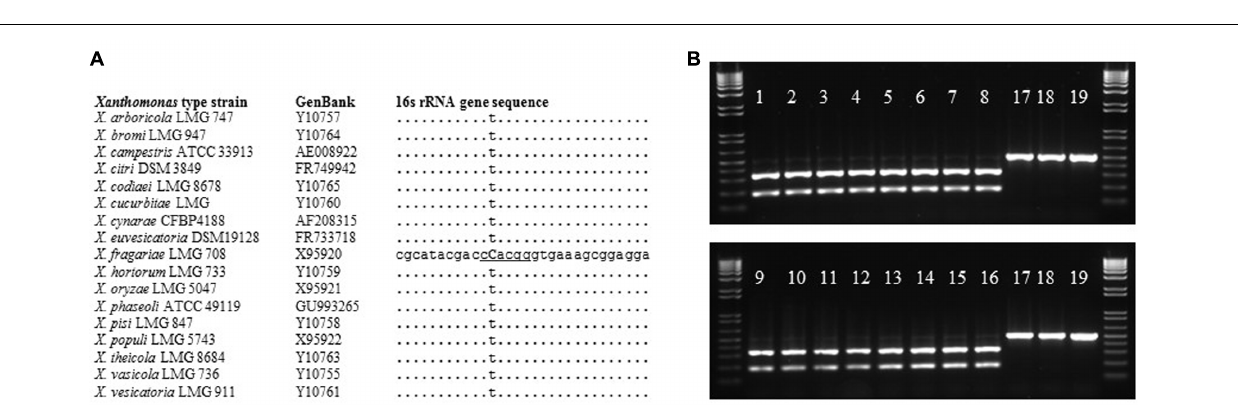
FIGURE 1 | (A) PCR-based confirmation of Xanthomonas fragariae identity for selected Fa P isolates from ALS-symptomatic strawberry plants, using X. fragariae -specific primers q241, q245, and q295 (Turechek et al., 2008). Expected amplicon sizes are 60, 65, and 71 base pairs, respectively. Lanes 1: Fa P21, 2: Fa P25, 3: Fa P29, 4: Fa P33. Lanes 5 through 9 are negative controls, 5: Xanthomonas campestris Fa P1, 6: X. campestris Fa P7, 7: Pseudomonas putida 1290, 8: Collimonas fungivorans Ter331, and 9: no template control. Inset shows the characteristic yellow color of X. fragariae colonies on WBN agar plates. (B) Typical ALS symptoms (water-soaked lesions) following inoculation of strawberry with X. fragariae Fa P21 or Fa P29. Shown is the same leaf illuminated from above (top photograph) or below (bottom).